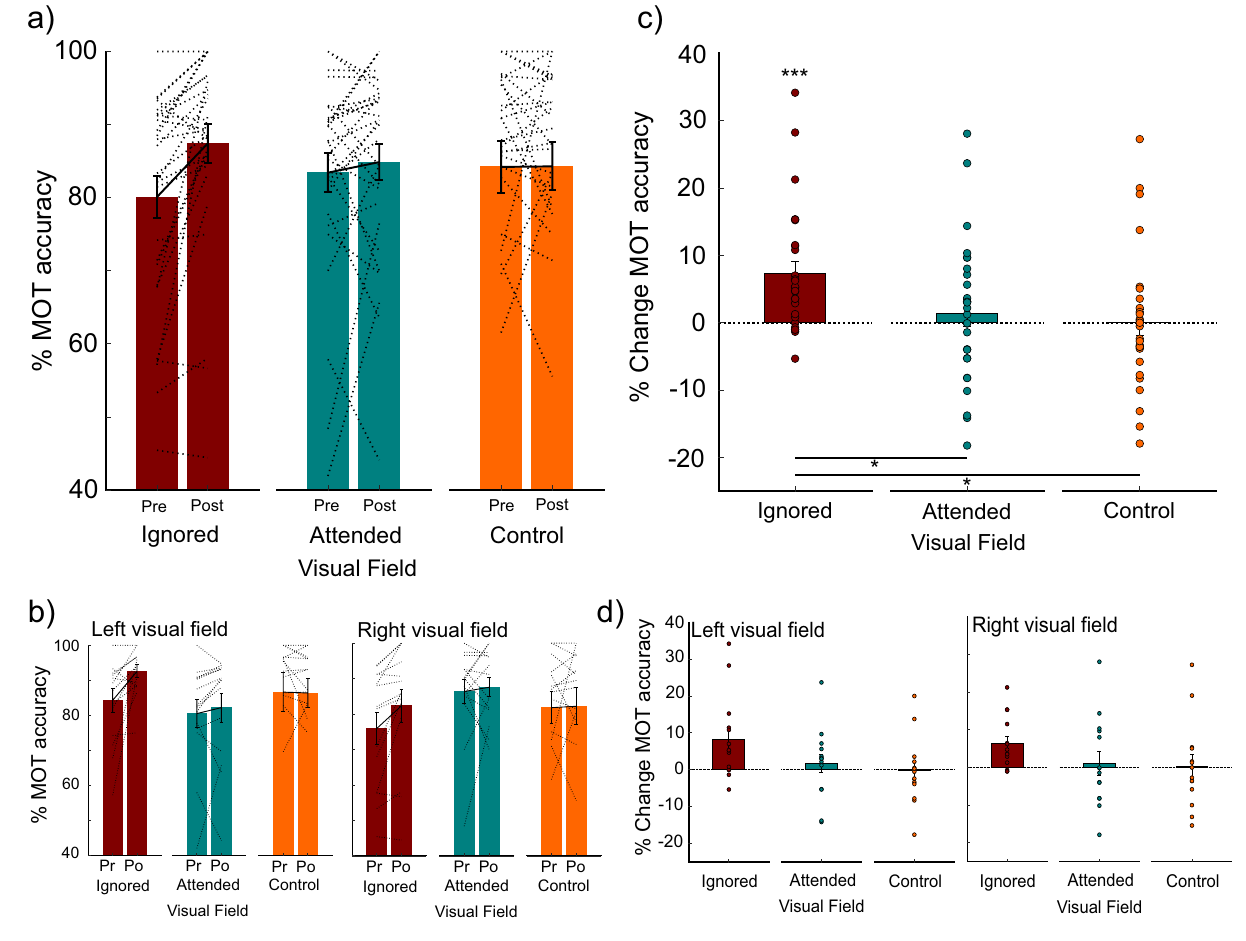
Figure 2. Percentage and percentage change MOT accuracy for pre- and post-manipulation. ( a ) Pre- and post- manipulation percentage correct MOT accuracy collapsed across left and right visual fields for ignored visual field (maroon bars), attended visual field (teal bars) and Control condition (orange bars). Dotted lines represent individual subject data. ( b ) Pre- and post-manipulation separated by visual field. ( c ) Percentage change in MOT accuracy. Asterisks above bars indicate significant difference from pre- to post-manipulation (*** p = 0.0001 maroon bars; * p = 0.0205 between Ignored and Control; * p = 0.0439, between Ignored and Attended). ( d ) Data separated by visual field, demonstrating no difference if manipulation is performed in right or left visual